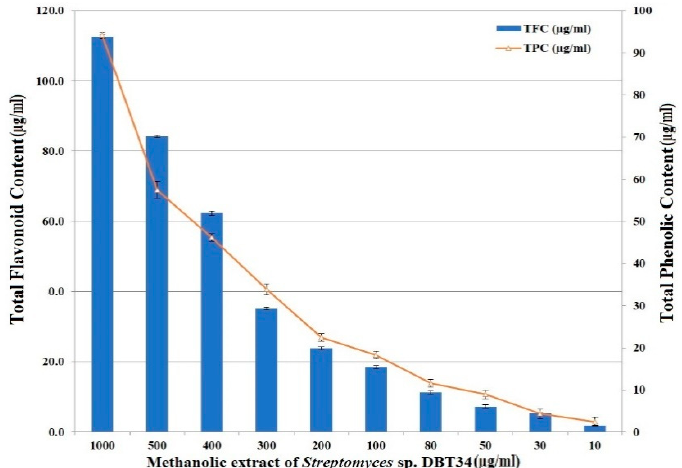
Figure 2. Total phenolic content and total flavanoid content in the methanolic extract of Streptomyces sp. strain DBT34. Data represents the mean ± SD.